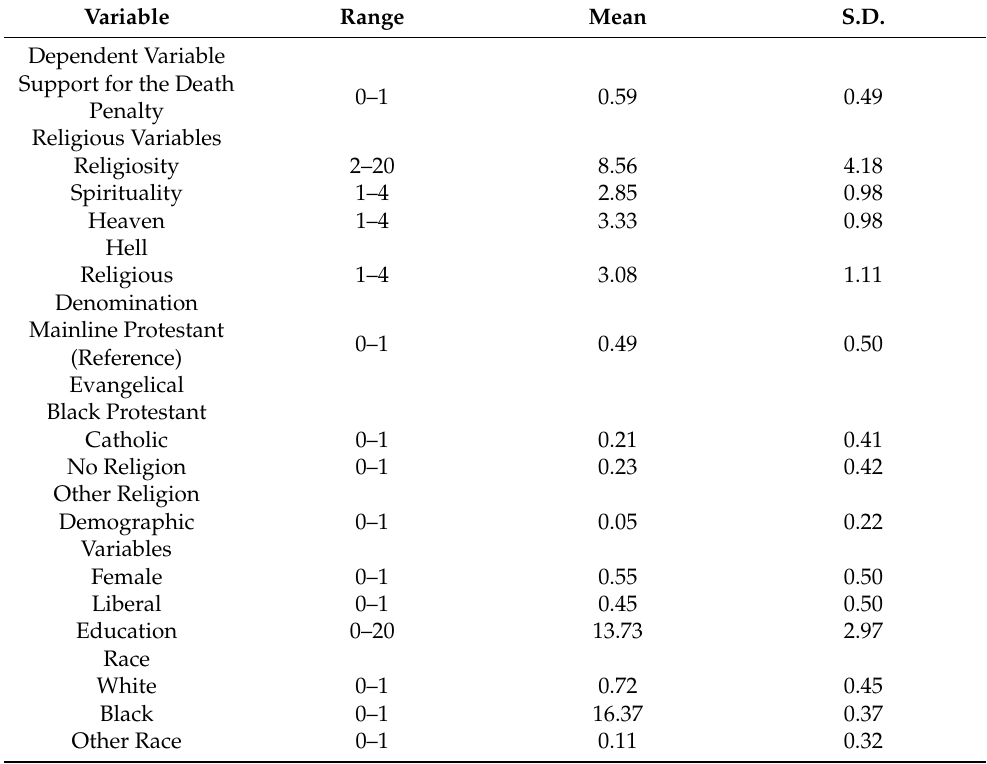
Table 1. Descriptive statistics for all variables (N =